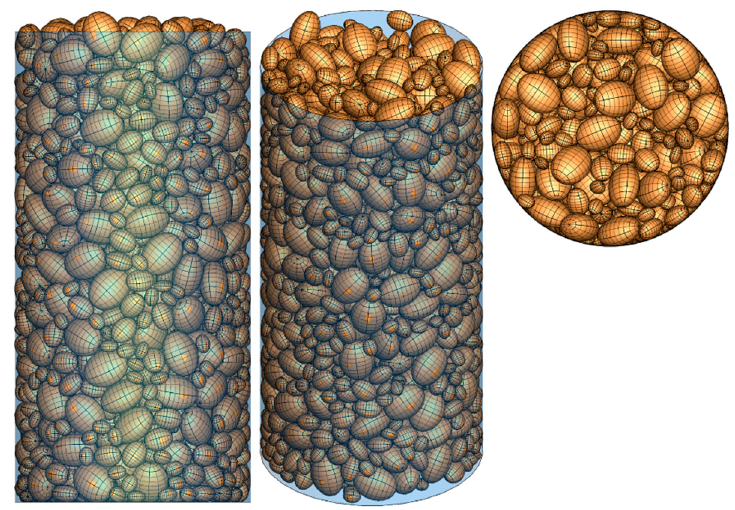
Figure 5. Removal of the particles outside of the specimen. Figure 4. Removal of the particles outside of the specimen. Materials 2019 , 12 , x FOR PEER REVIEW